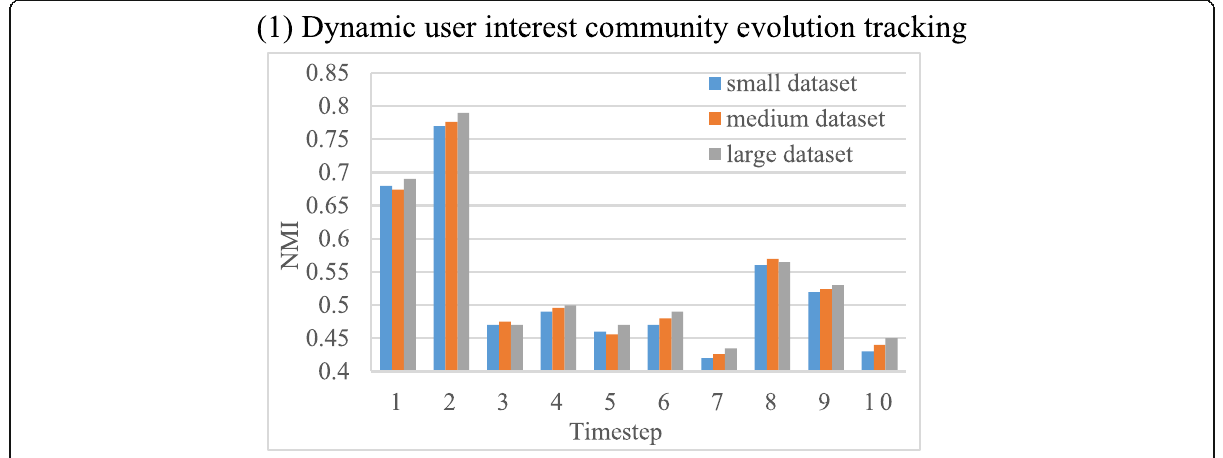
Fig. 9 NMI values comparison on different datasets